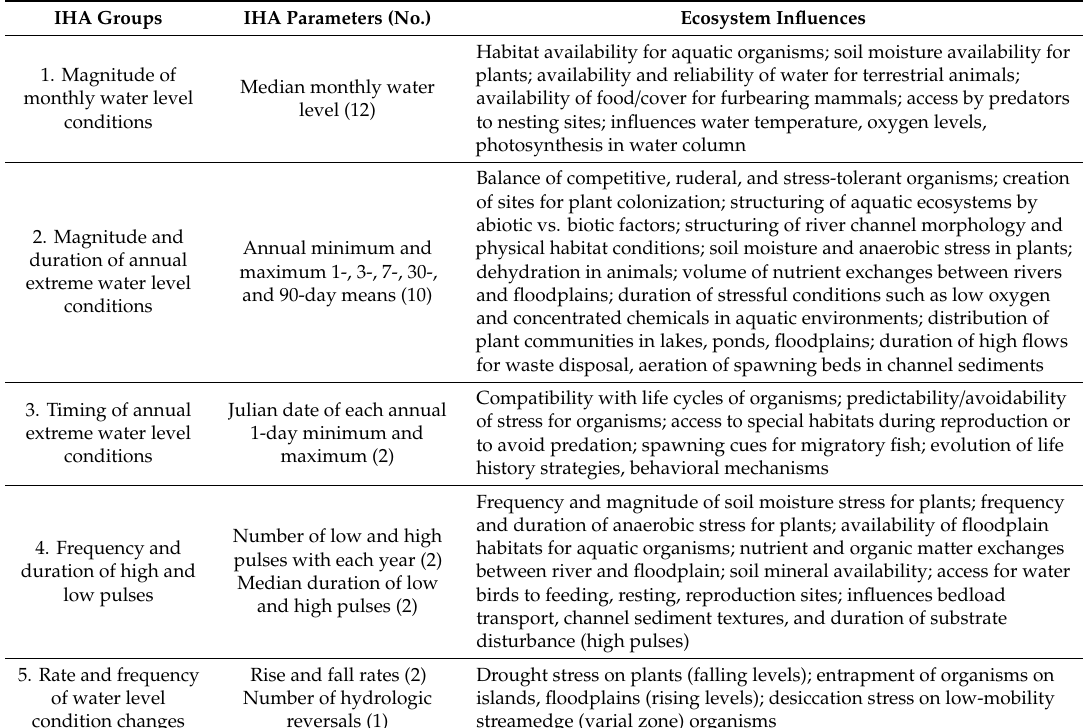
Table 2. IHA groups, parameters, and their ecosystem influences [49]. Indicators of “number of zero-flow days” and “base flow index” in Group 2 were eliminated from this